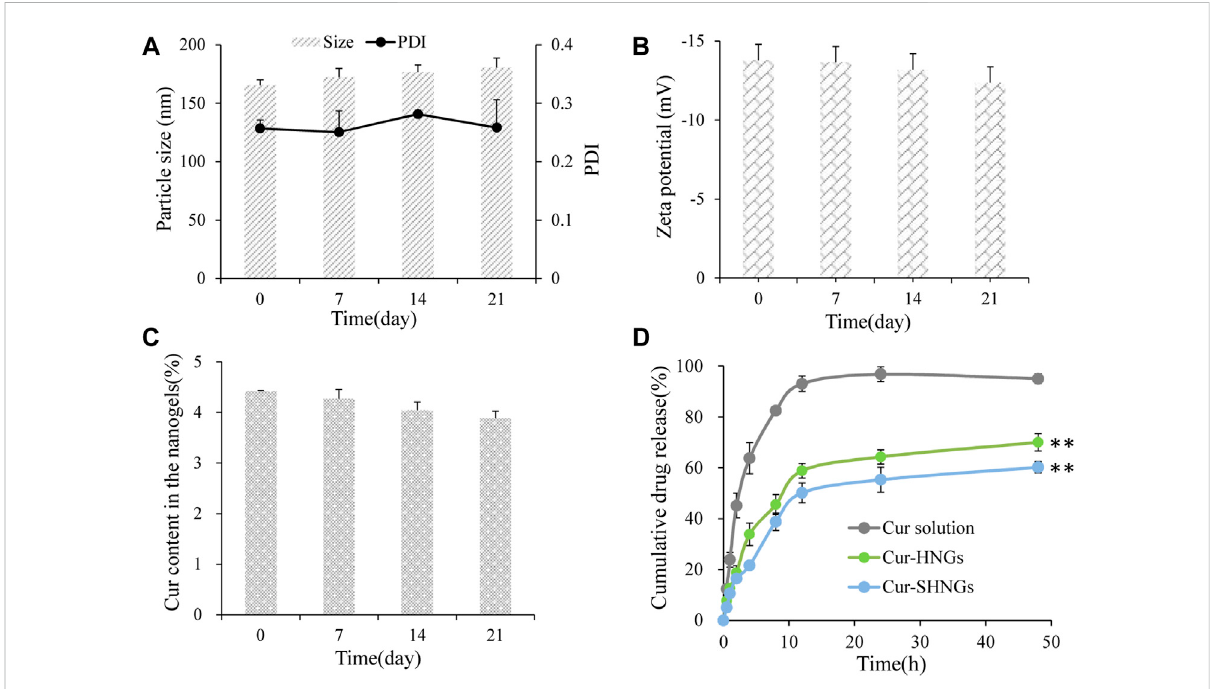
FIGURE 4 The storage stability of Cur-SHNGs at 4 ° C by (A) particle size and PDI, (B) zeta potential and (C) Cur content in the nanogels. (D) The in vitro releaseofCurfromCursolution,Cur-HNGs,andCur-SHNGsinPBS(pH7.4)containingethanol(40%,v/v)(resultswerepresentedasmean±SD, n = 3; ** p < 0.01 compared with the Cur solution).